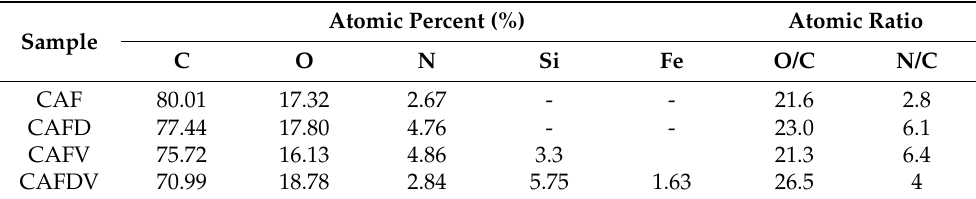
Figure 6. XPS spectra of aramid continuous fiber: ( a ) original, ( b ) vinyl triethoxysilane- treated, ( c ) dopamine-treated, and ( d ) dopamine and vinyl triethoxysilane-treated. Table 2. Surface elemental composition of CAF.